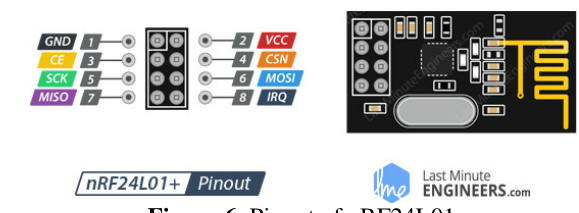
Figure 6. Pinout of nRF24L01